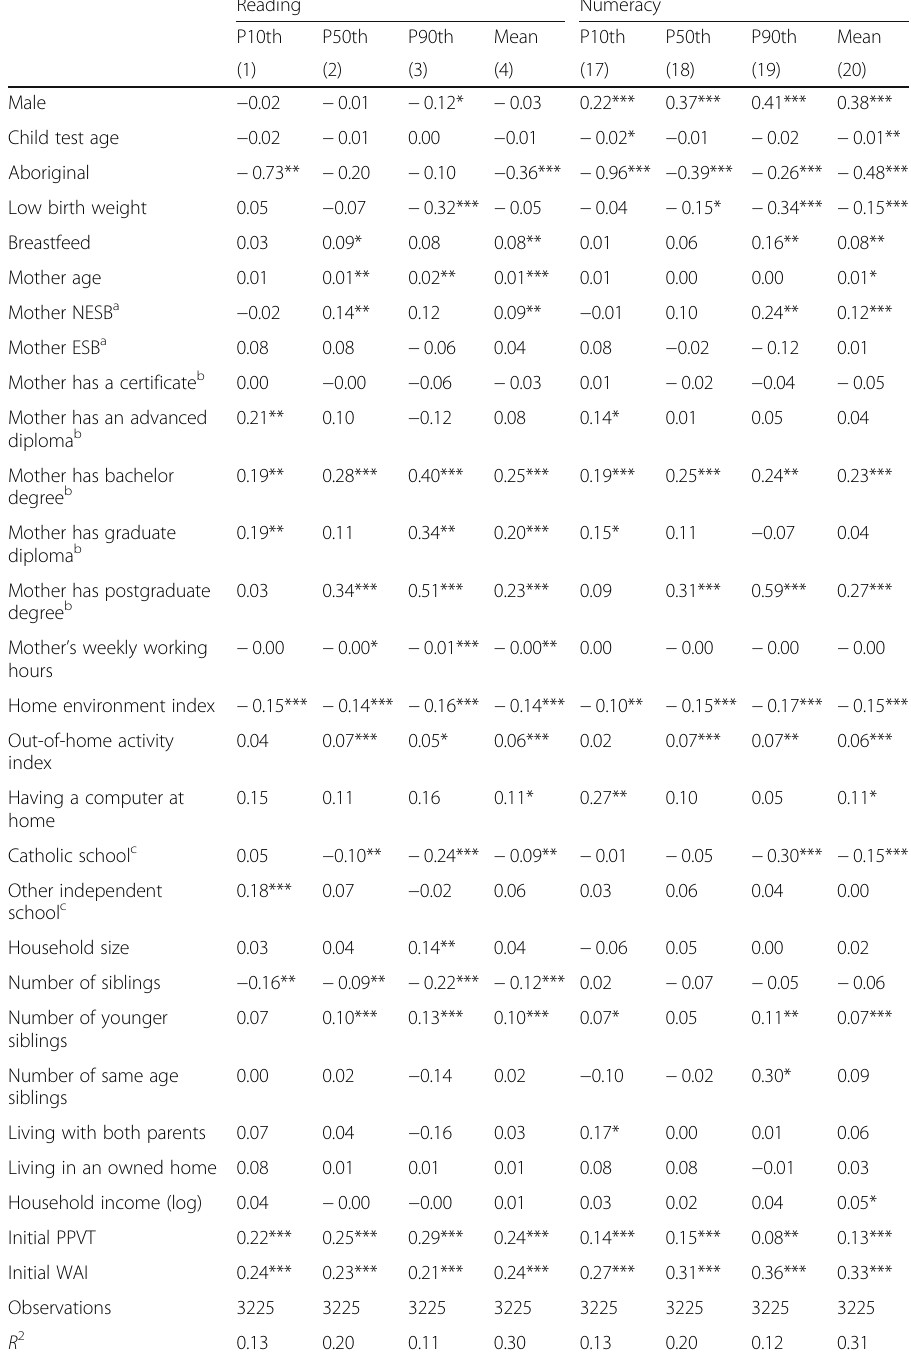
Table 10 Full regression results at selected percentiles and at mean — grade 5